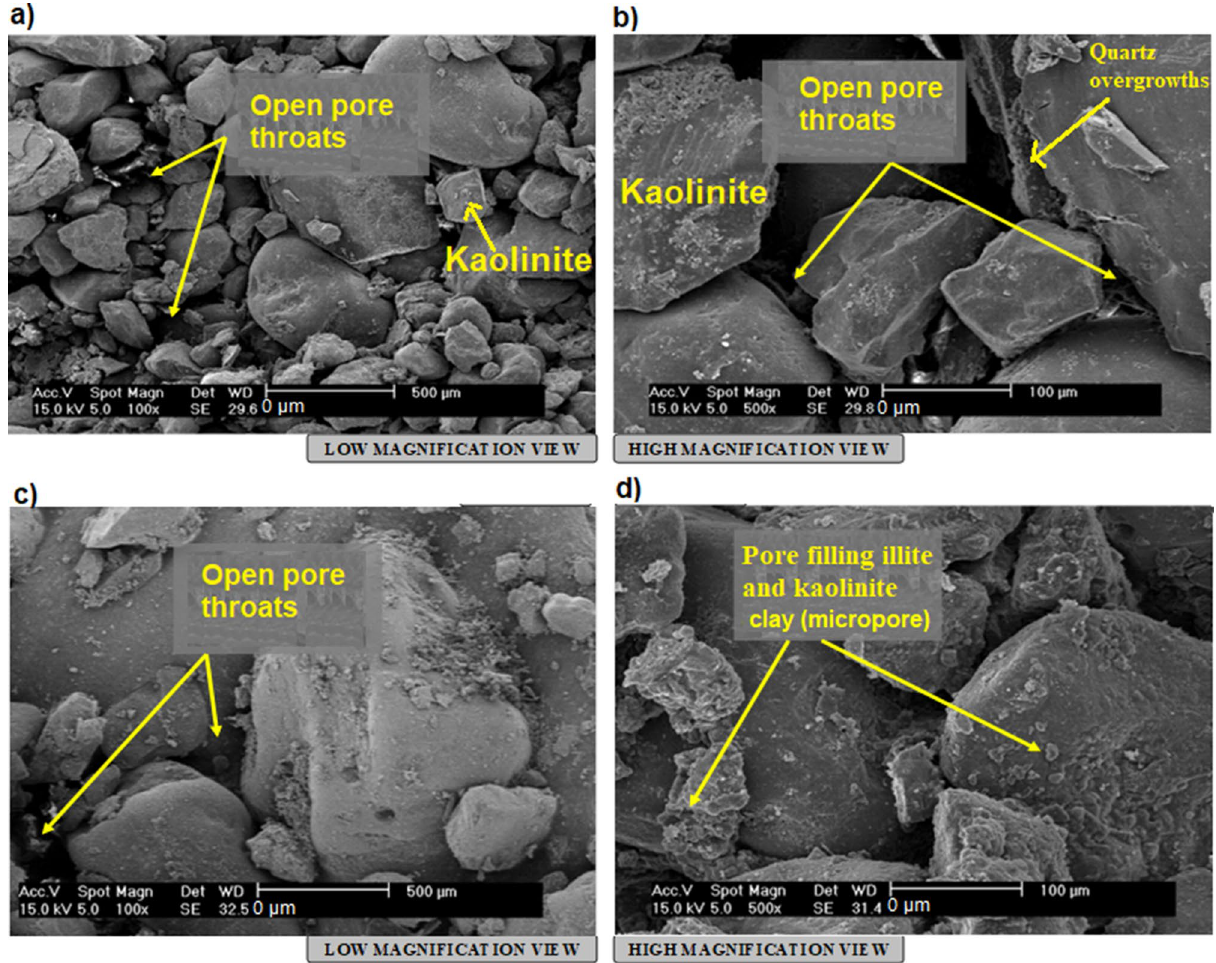
Figure 15. Microscopic photos obtained by SEM showing open pore throats, pore filling illite (micropores) and kaolinite as well as quartz and quartz overgrowths.